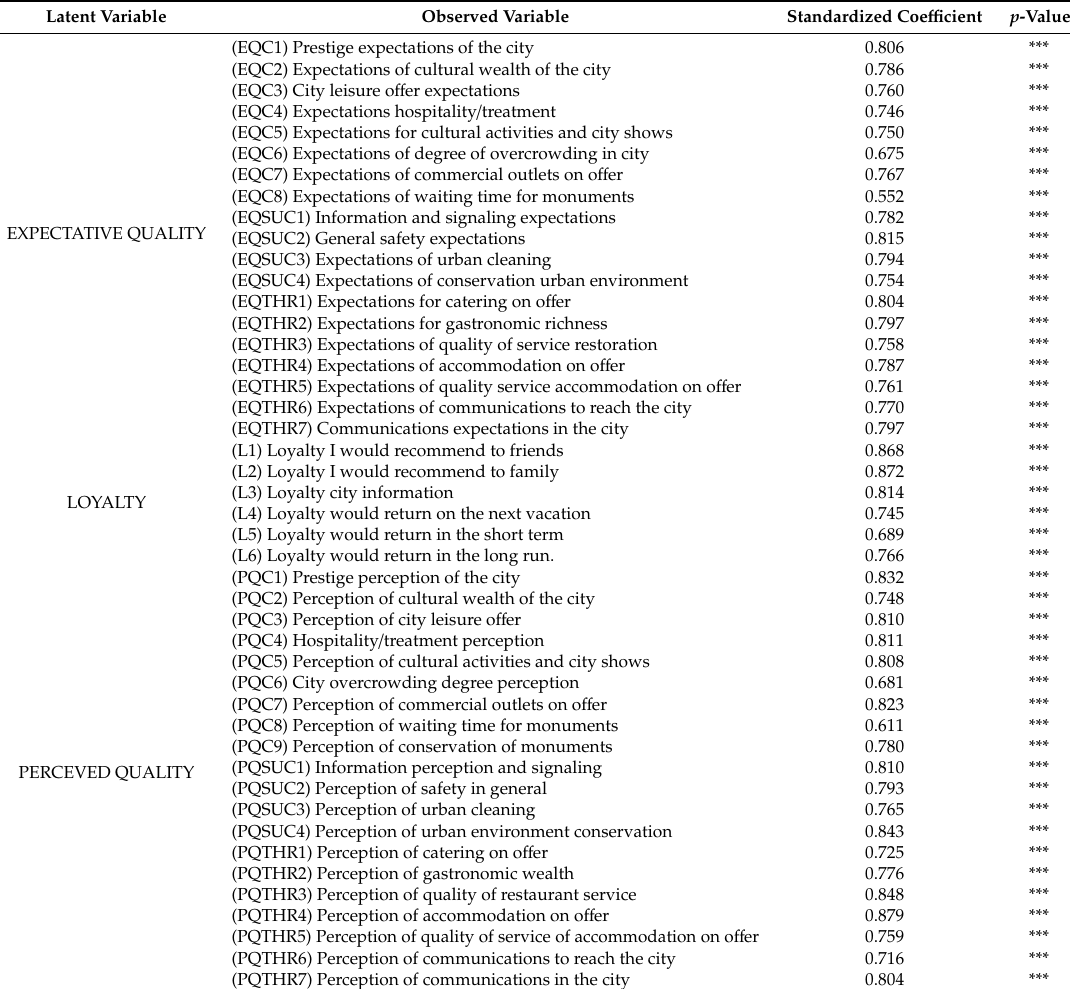
Table 3. Standardized structural coe ffi cients of the observed